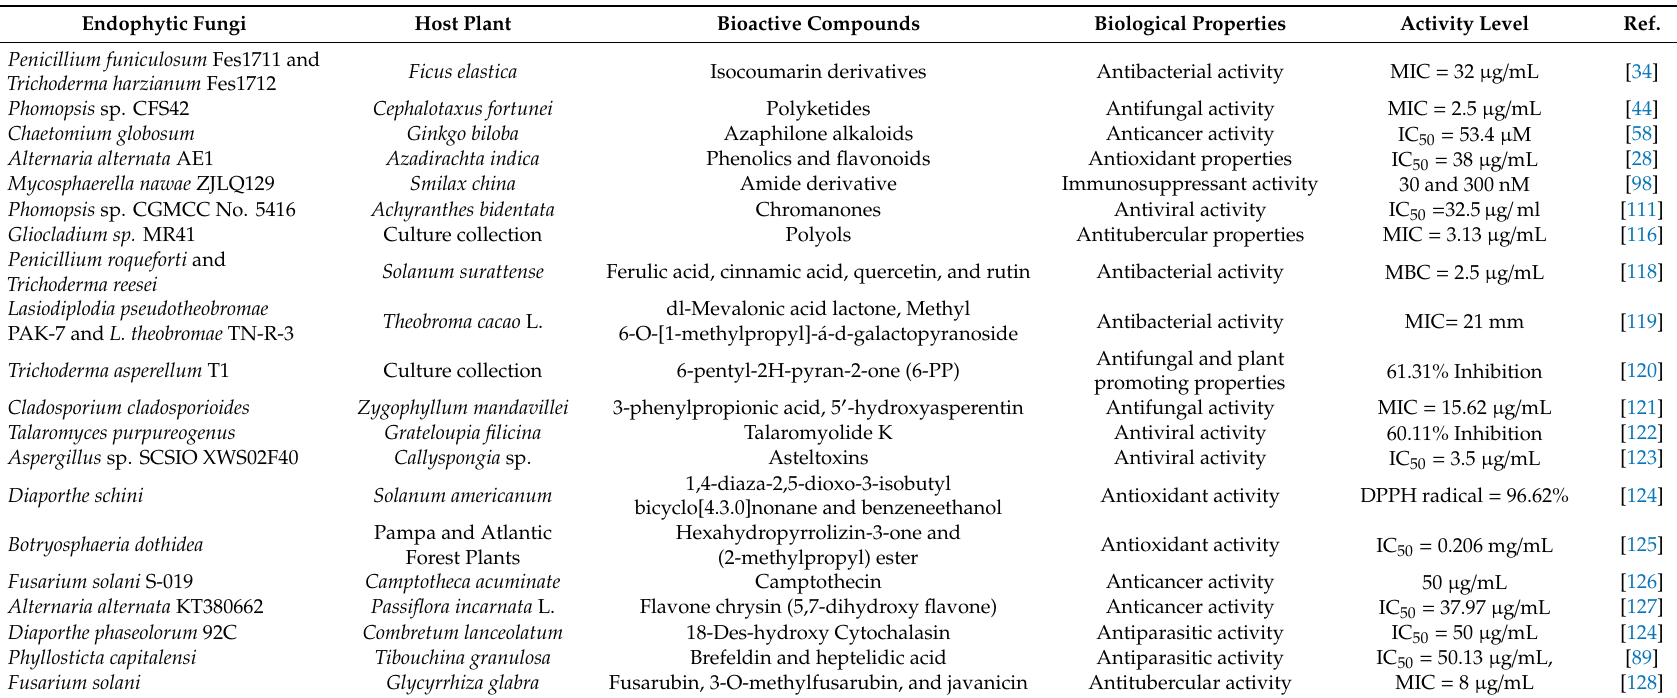
Table 2. List of some bioactive compounds produced by endophytic fungi possessing biological